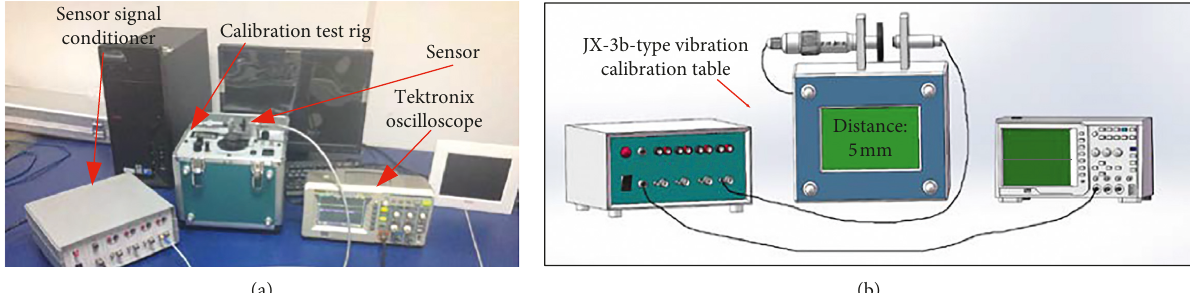
Figure 8: The calibration system for the eddy current displacement sensor.